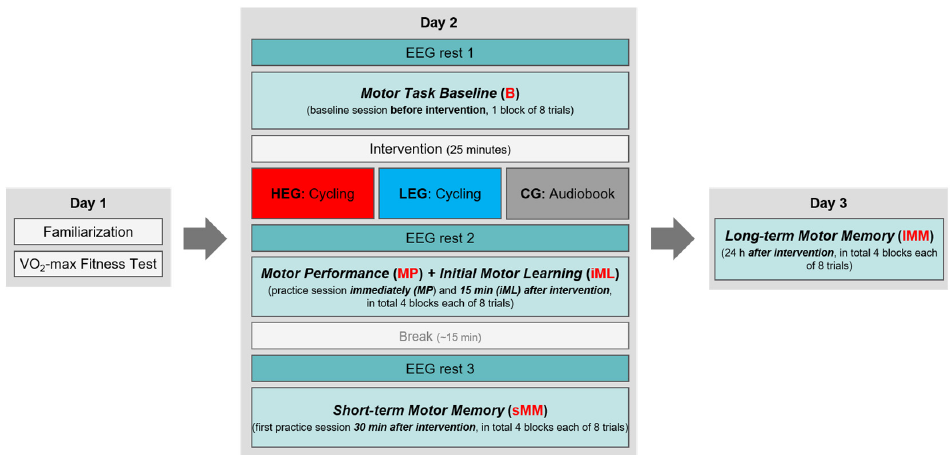
Figure 2. Schematic illustration of the study design: Text in bold italics represents timepoints of the FM task included for statistical analyses (each timepoint consists of 1 block of 8 trials). EEG boxes denote the timepoints of EEG measurement during rest, while EEG was also measured continuously during the FM task on day 2.